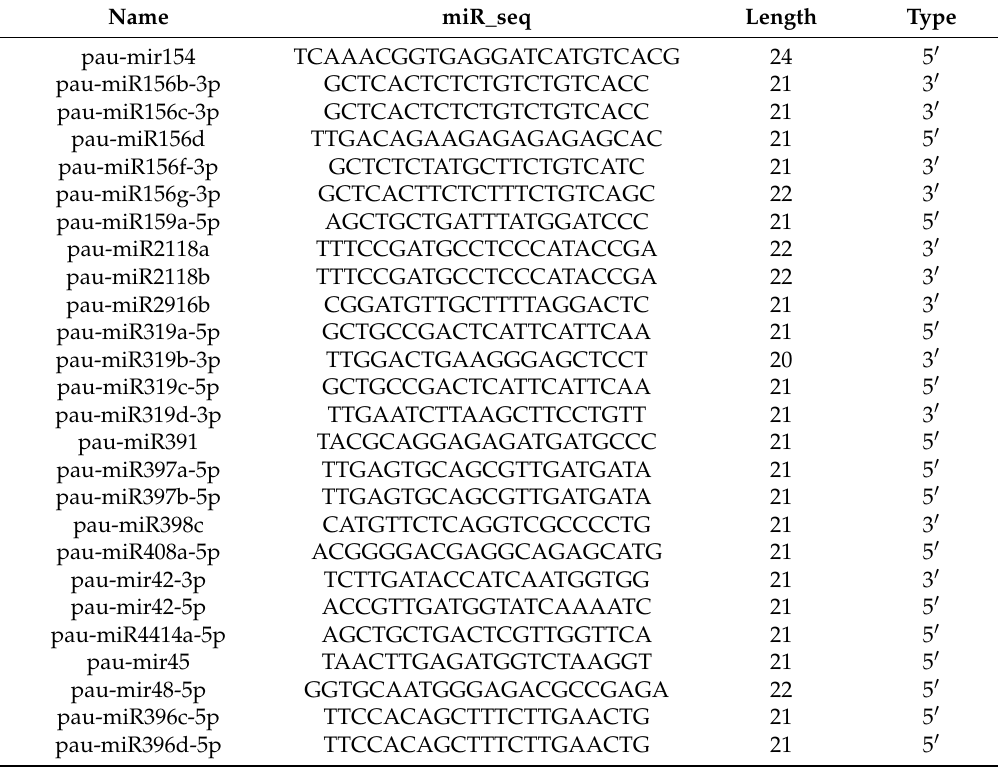
Table 1. The miRNA associated with